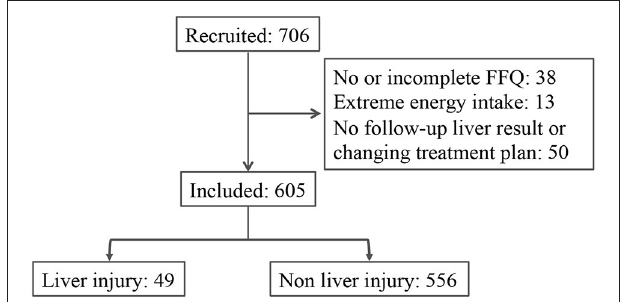
FIGURE 1 | The trial